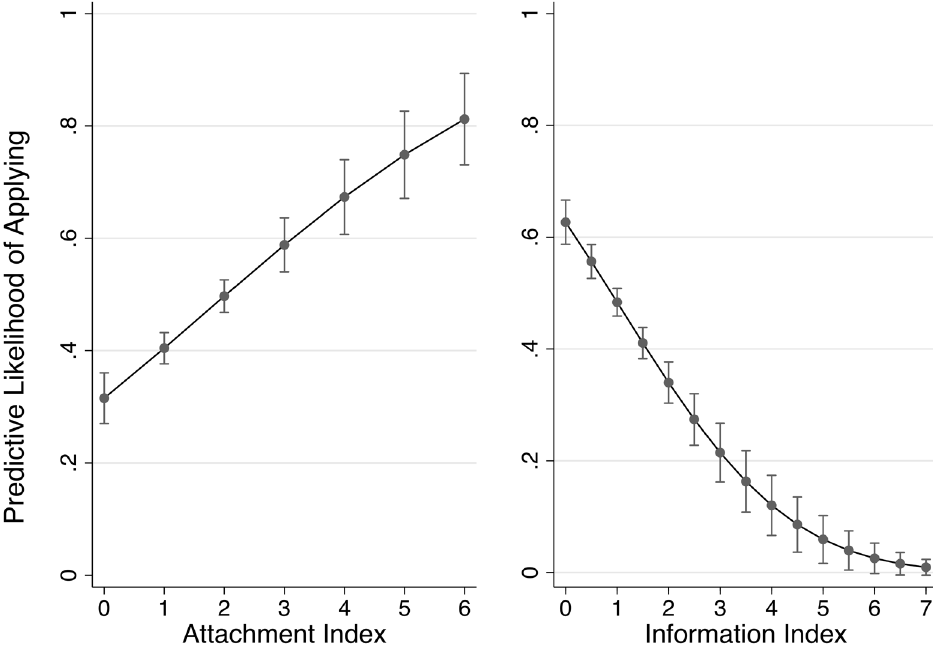
Fig 2. Predictive marginal effects of attachment and information indices. Predictive marginal effects and the likelihood of applying estimated from model (2) of Table 2 using factor polynomial fit. 95% CI is indicated for each unit of indices.